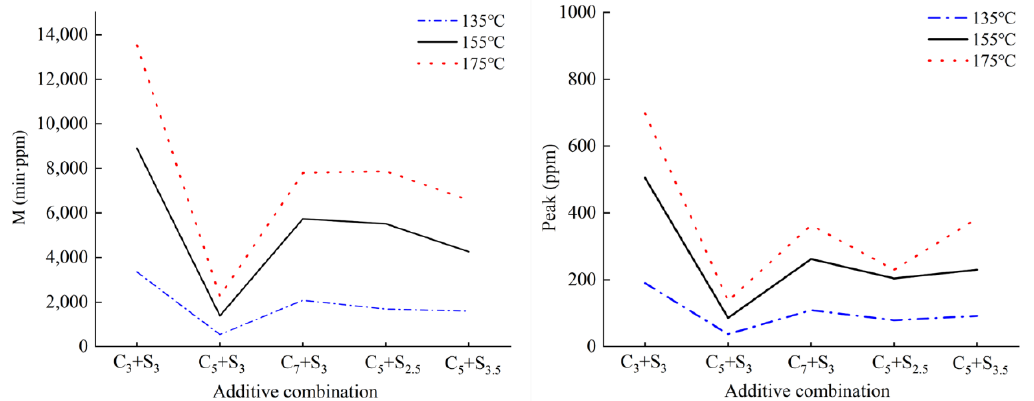
Figure 11. VOCs emission M and peak value P of environmentally friendly modified asphalt at different temperatures.